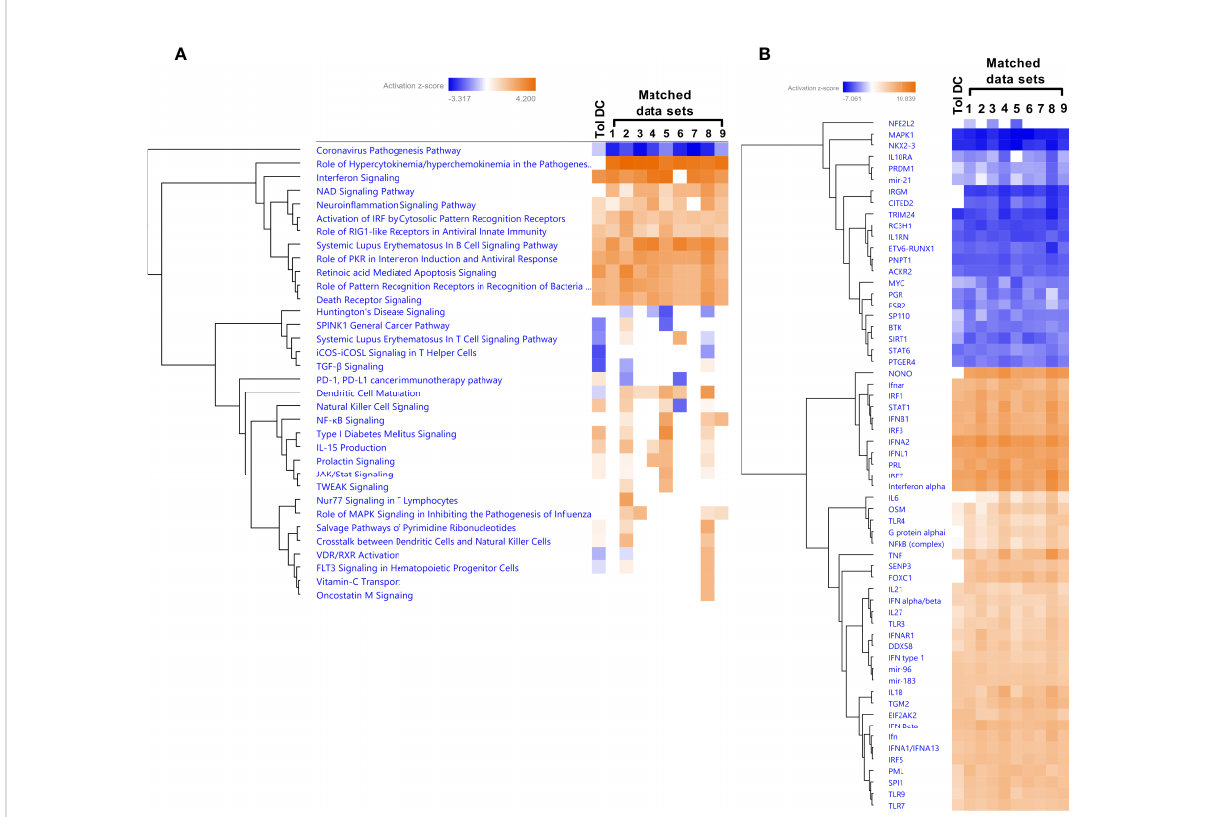
FIGURE 9 The HIV induced tolerogenic DCs had a high overlap with type I IFN exposure, and in fl uenza infection data in a match analysis. Transcriptomic tolerogenic DC data set (Tol DC) generated from 8 individual donors and experiments was analyzed using a match analysis with at least 86% match in IPA and the matching data sets were (1) 6- normal control [lung] co-culture;in fl uenza A;low glucose 4569, (2) 4- lung adenocarcinoma (LUAD) [alveoli] Infection_in fl uenza A 16703, (3) 4- normal control [peripheral blood] culture medium 26822, (4) 10- disease control [peripheral blood] NA 4160, (5) 17- hepatocellular carcinoma (LIHC) [liver] IFN lambda 1 19882, (6) 3- normal control [lung] co-culture; high glucose;in fl uenza A 4566, (7) 1- normal control [lung] co-culture; high glucose;in fl uenza A 4564, (8) 1- pustular psoriasis [peripheral blood] NA 3612, 6- normal control [lung] co-culture;in fl uenza A;low glucose 4569, and (9) 5- normal control [peripheral blood] NA 10198. Transcriptomic data set match analysis with top canonical pathways shown as hierarchic clustered heatmap with a threshold for p-values set to -log 1.3 (p<0.05) and Z-score 2 (A) . Transcriptomic data set match analysis with Upstream regulator shown as hierarchic clustered heatmap with a threshold for p-values set to log 1.3 (p<0.05) and Z-score 4 (B)